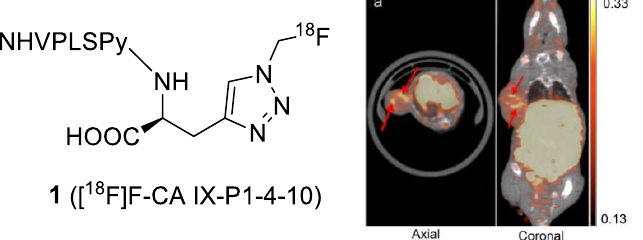
Figure 2. MicroPET/CT images acquired at 1 h PI of [ 18 F]F-CaIX-P1-4-10 in HT-29 colorectal cancer xenograft-bearing mice. Arrows indicate high-count density regions in the tumor. The units of the bar scale are standard uptake values (SUVs).